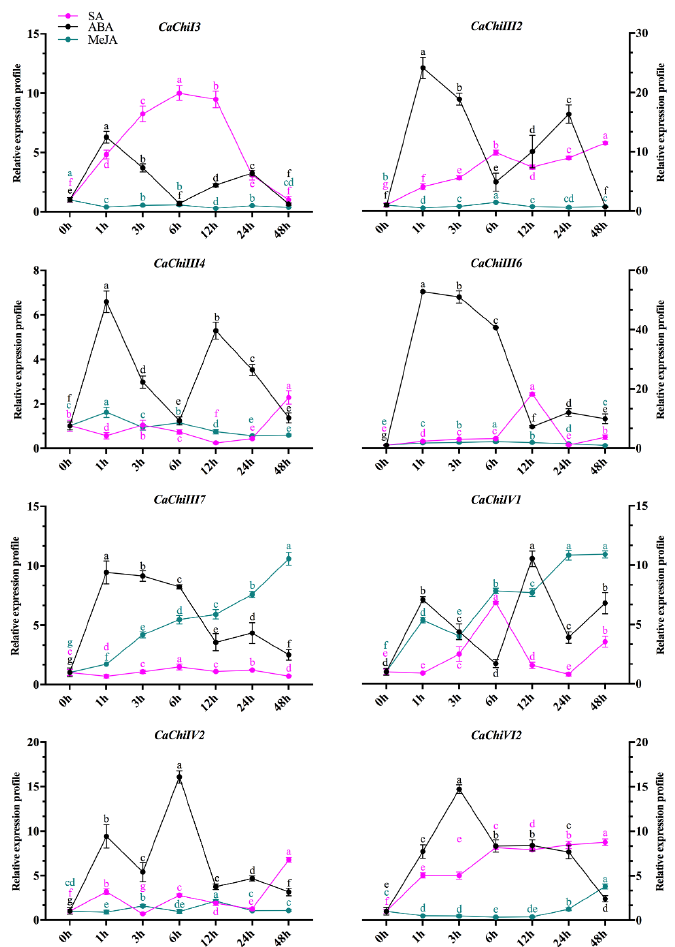
Figure 9. Expression profiles of CaChi in response hormones application. The inducible expression patterns performed by qRT-PCR under Salicylic acid (SA) and methyl-jasmonate (MeJA). Mean values and SDs for three replicates are shown. Small letters (a–f) represent significant differences ( p <